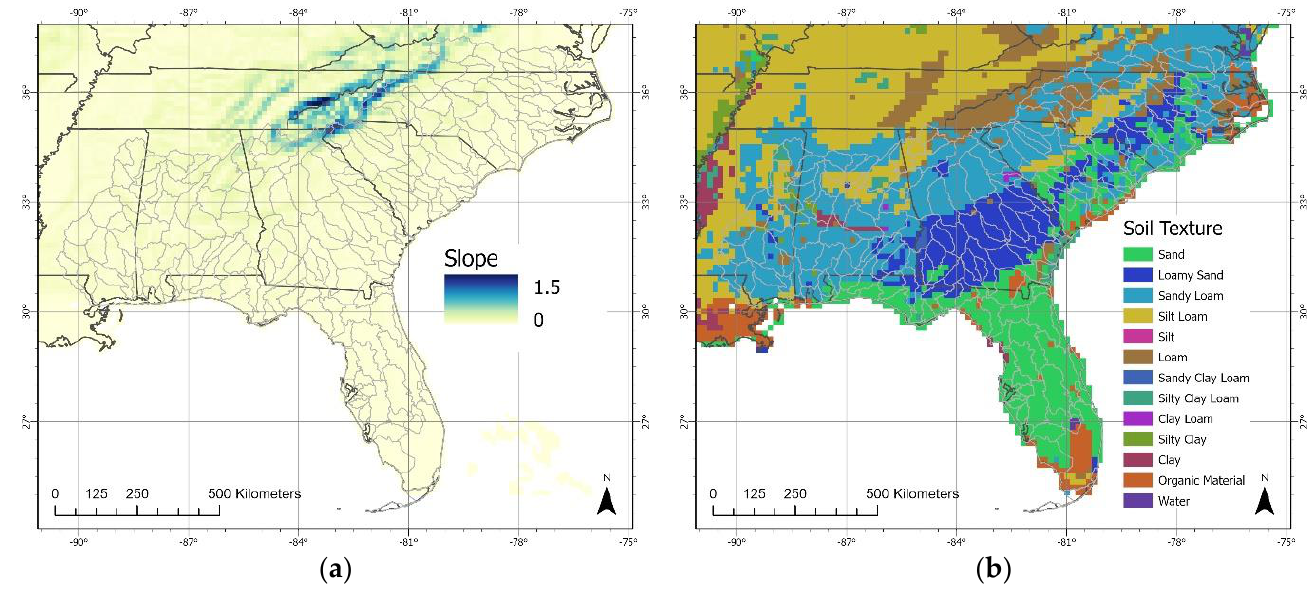
Figure 8. ( a ) Slope and ( b ) soil texture information for the Southeast US, derived from the NLDAS dataset that is used as input into the NWM retrospective v.2.0 data. Grey polygons delineate watersheds within the USGS Region 3 study area.